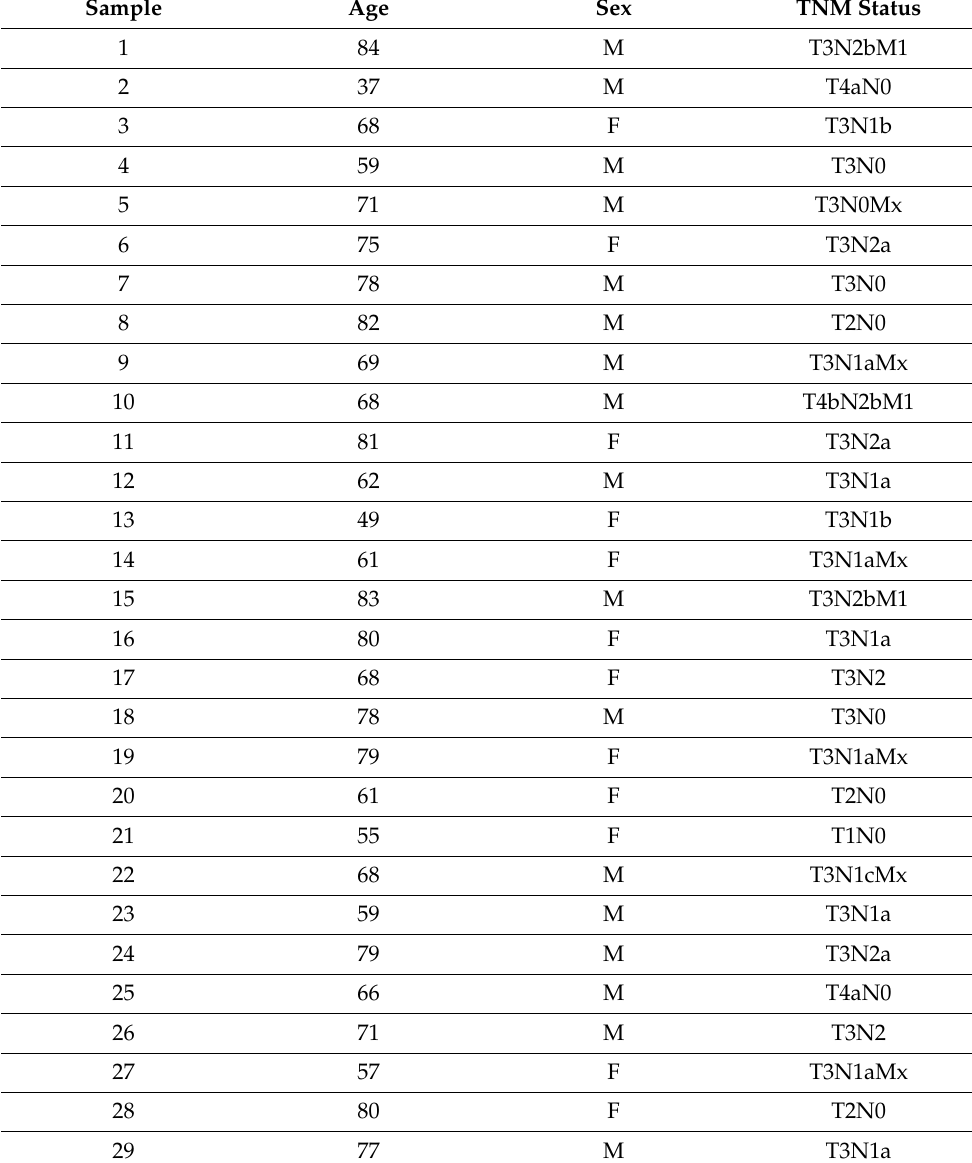
Table 1. Clinical data of COAD patients used qRT-PCR validation of BMP5, miR-27a-5p and miR-146a-5p.